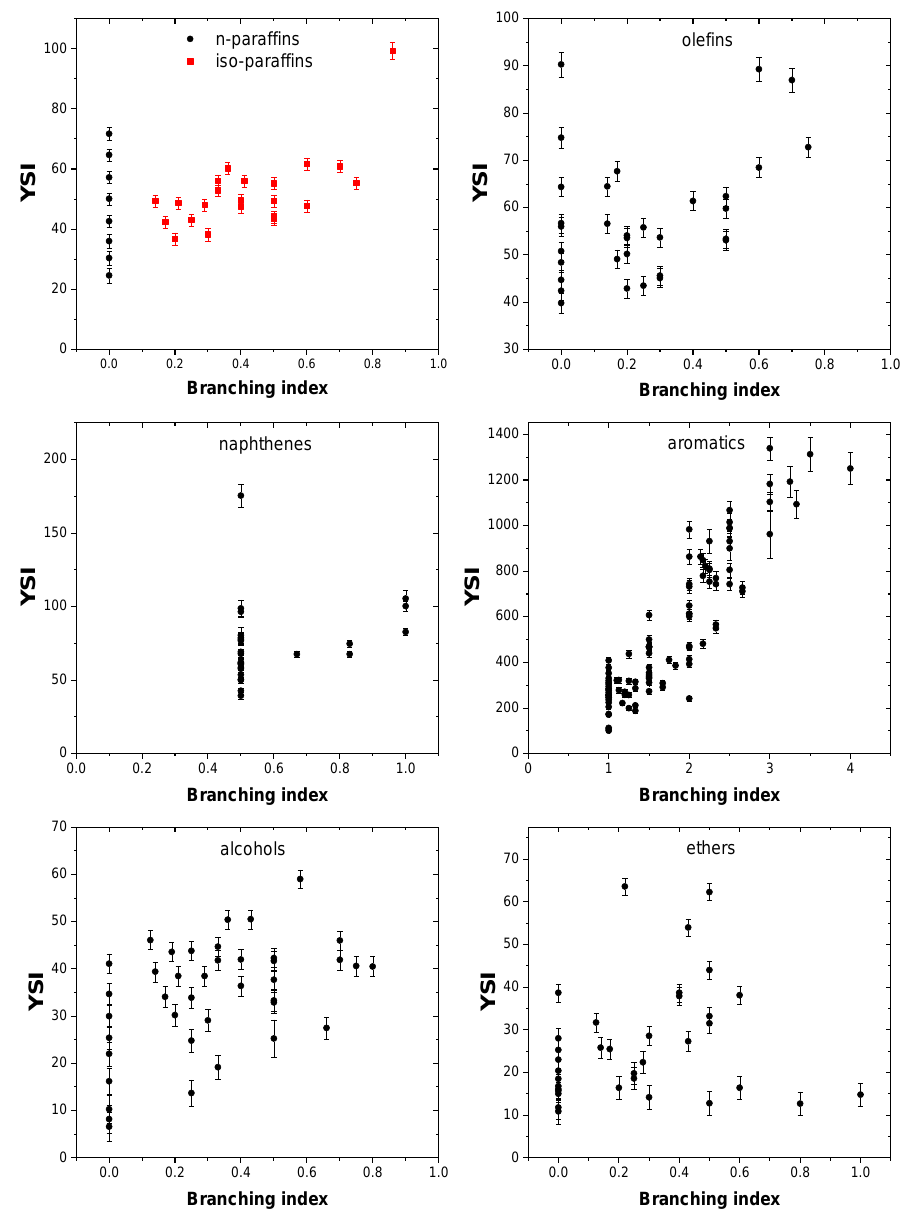
Figure 12. Effect of branching index on YSI .